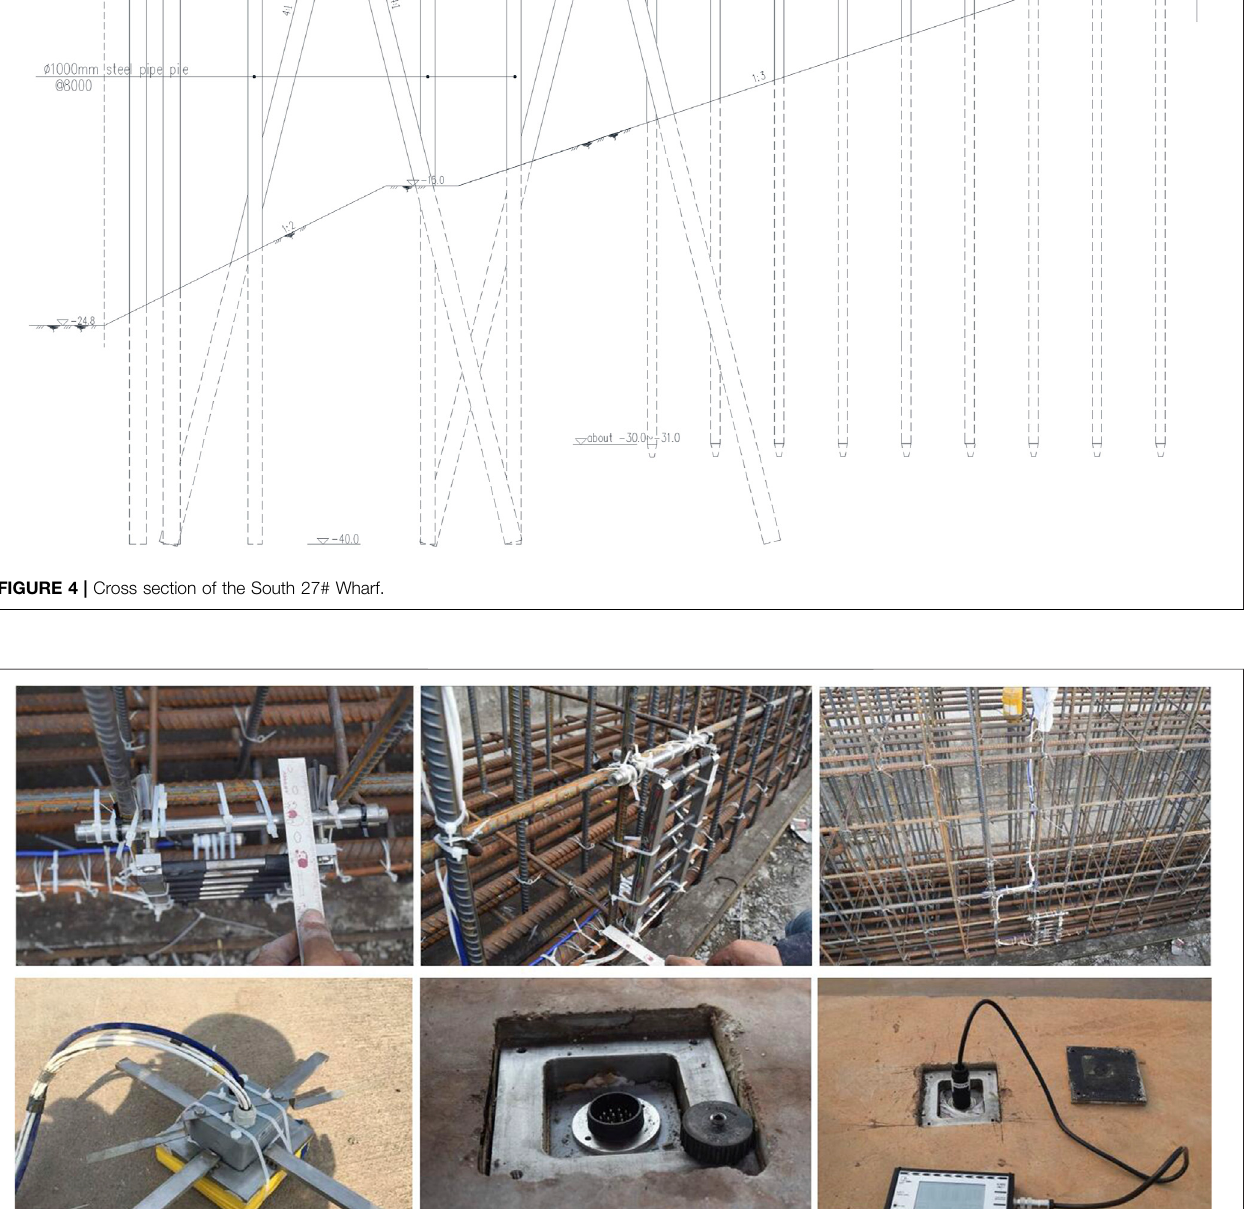
Frontiers in Materials |